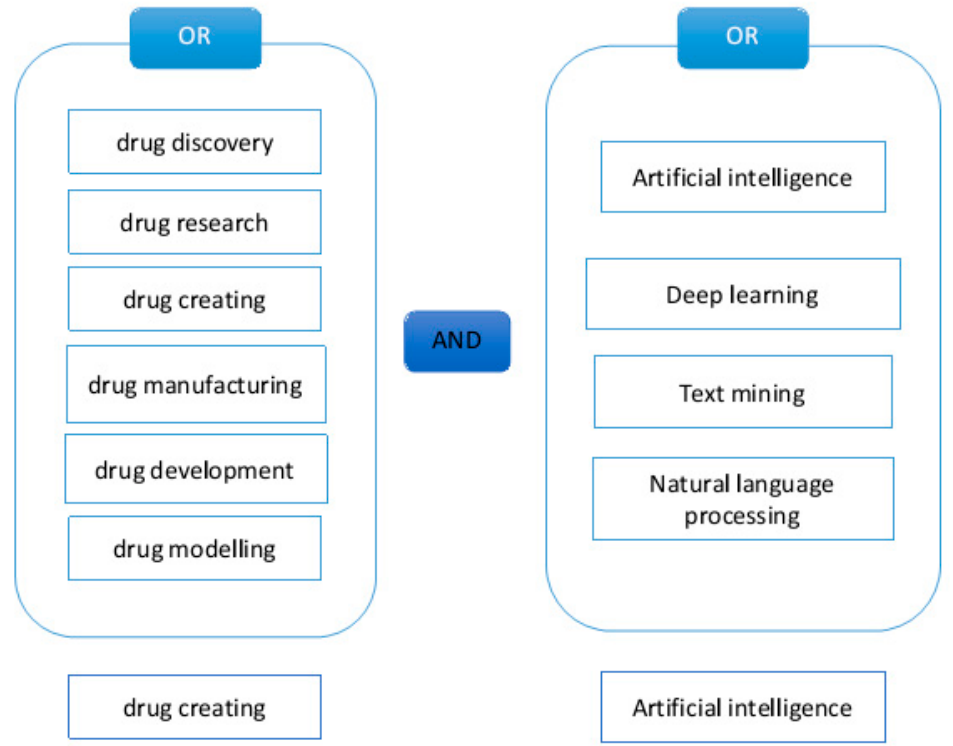
Figure 1. Graphical representation of a search query.